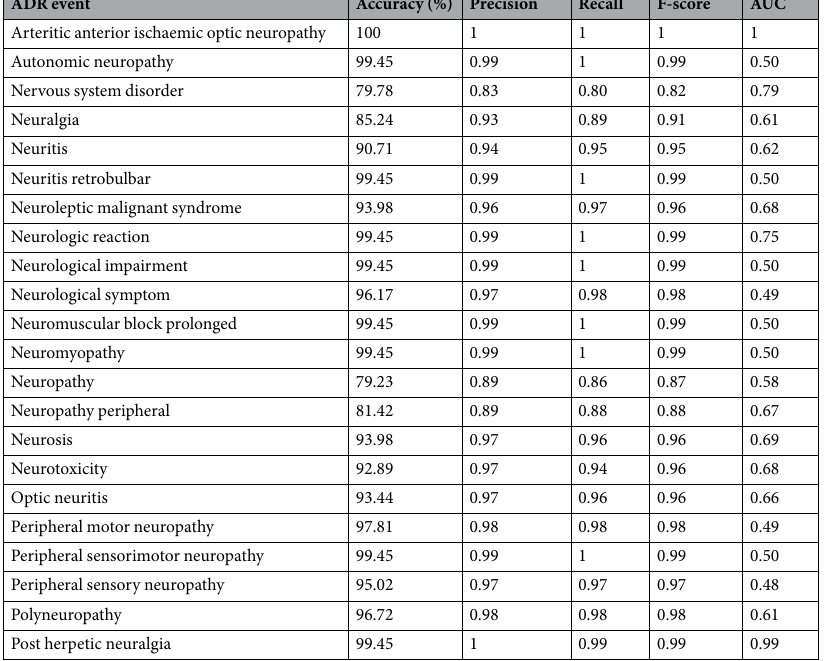
Table 9. Provides the performances of the models generated using the combination of the three levels of features, biological, chemical, and